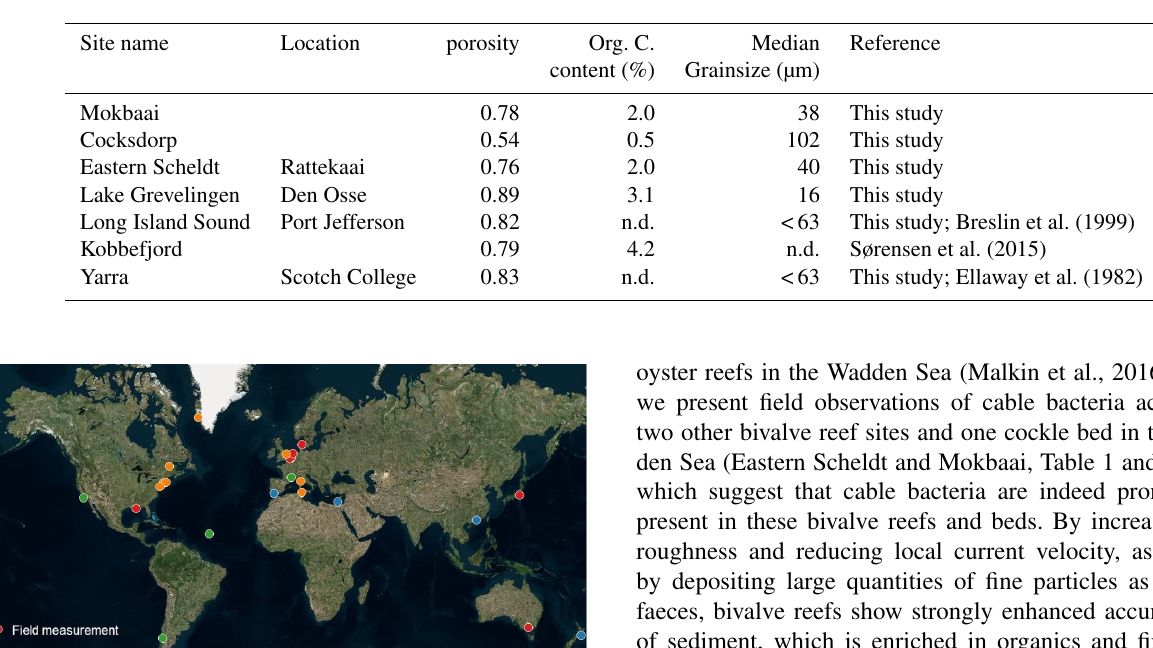
Table 2. Sediment characteristics for field sites with cable bacteria activity.